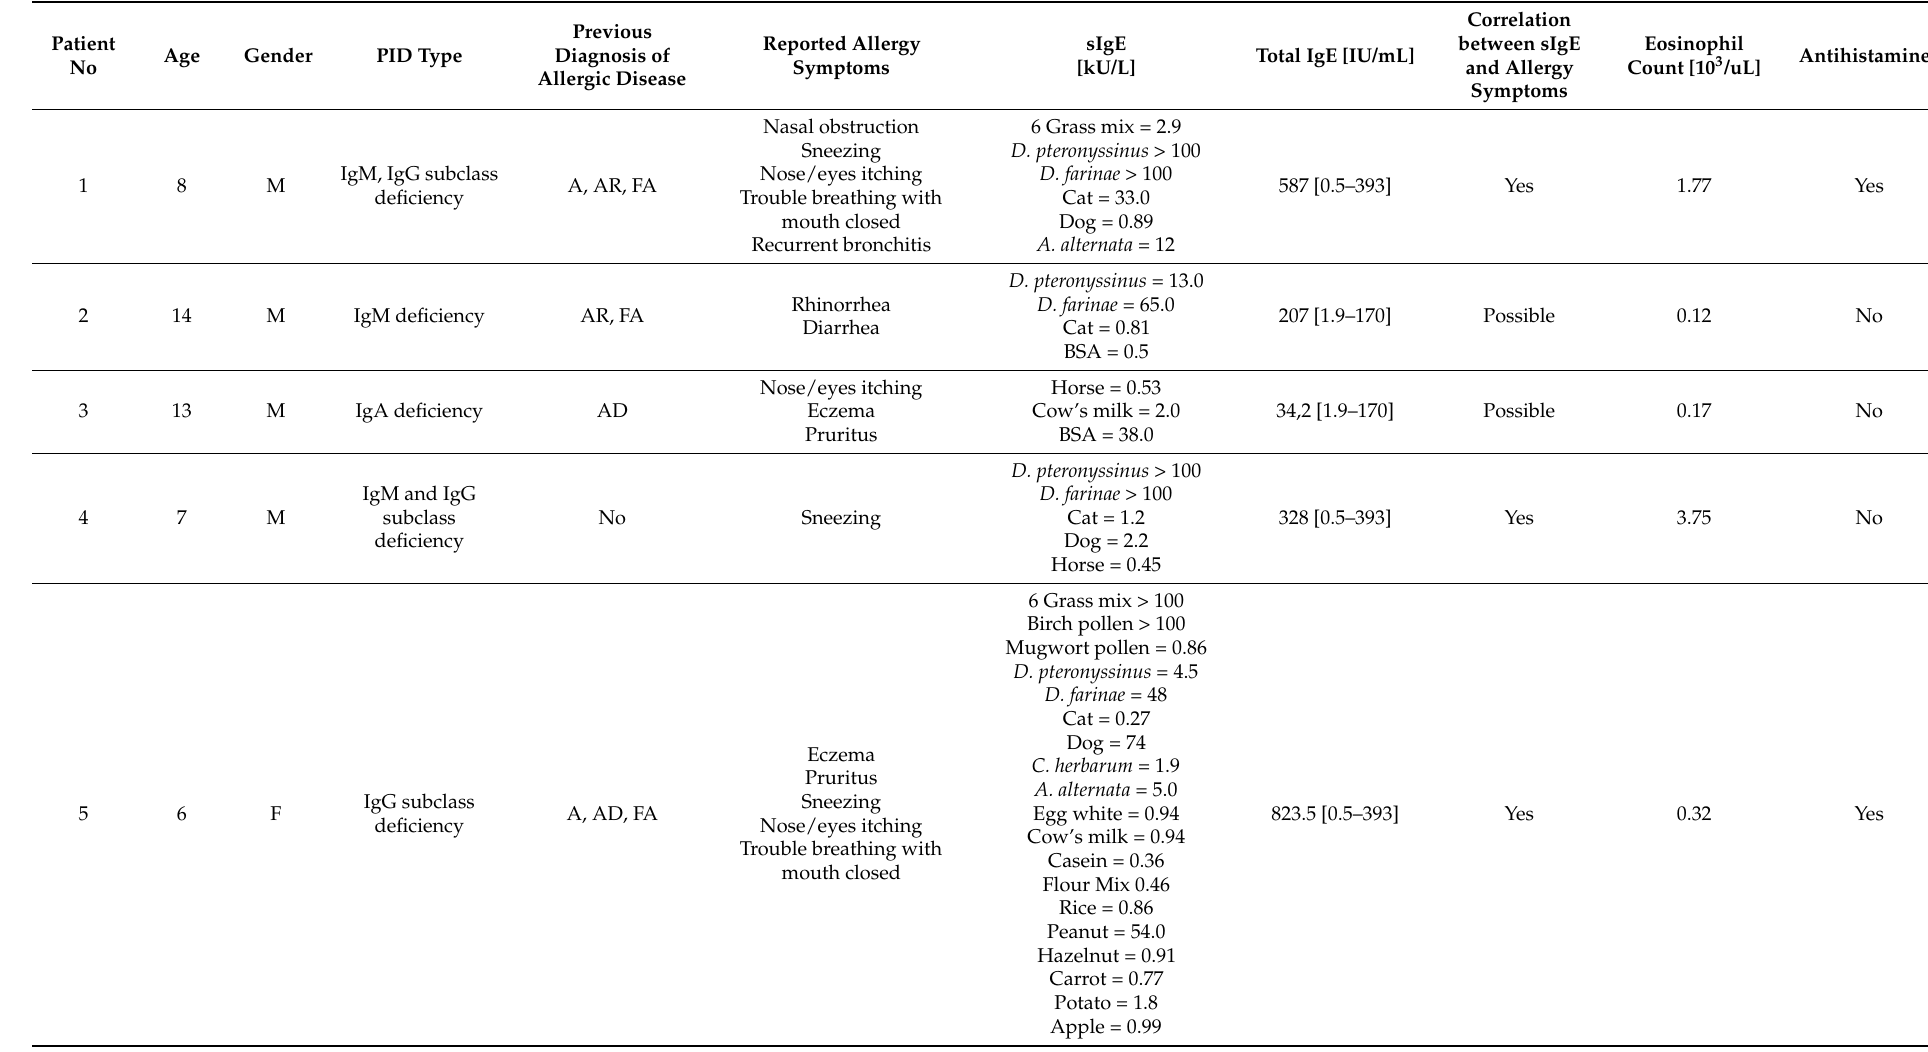
Table 1. Characteristics of patients with sIgE concentration ≥ 3.5